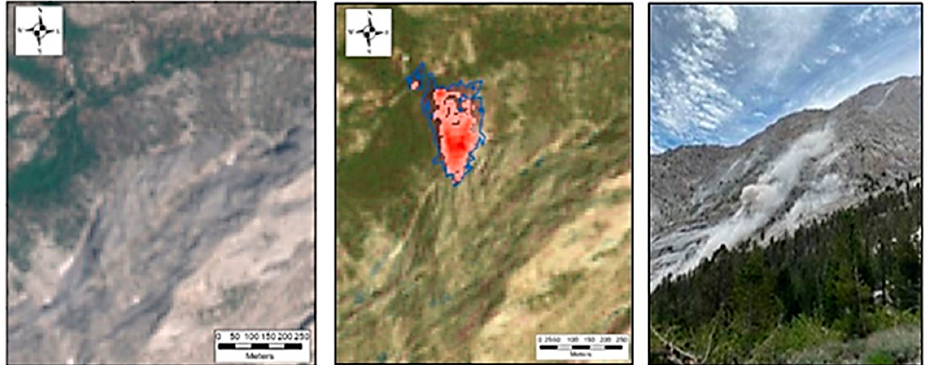
Figure 13. Whitney Portal rockfall (centered on 36.585°N 118.239°W). Left : 22 June 2020 pre-earthquake. Middle : differenced image post-earthquake. Red intensity reflects the level of difference change. Right : Whitney Portal rockfall from the Owens Lake event imaged to the ESE from Lone Pine Canyon along the Mount Whitney Trail at approximately 2800 m. Other small rockfalls can be seen to the left, right and above the main